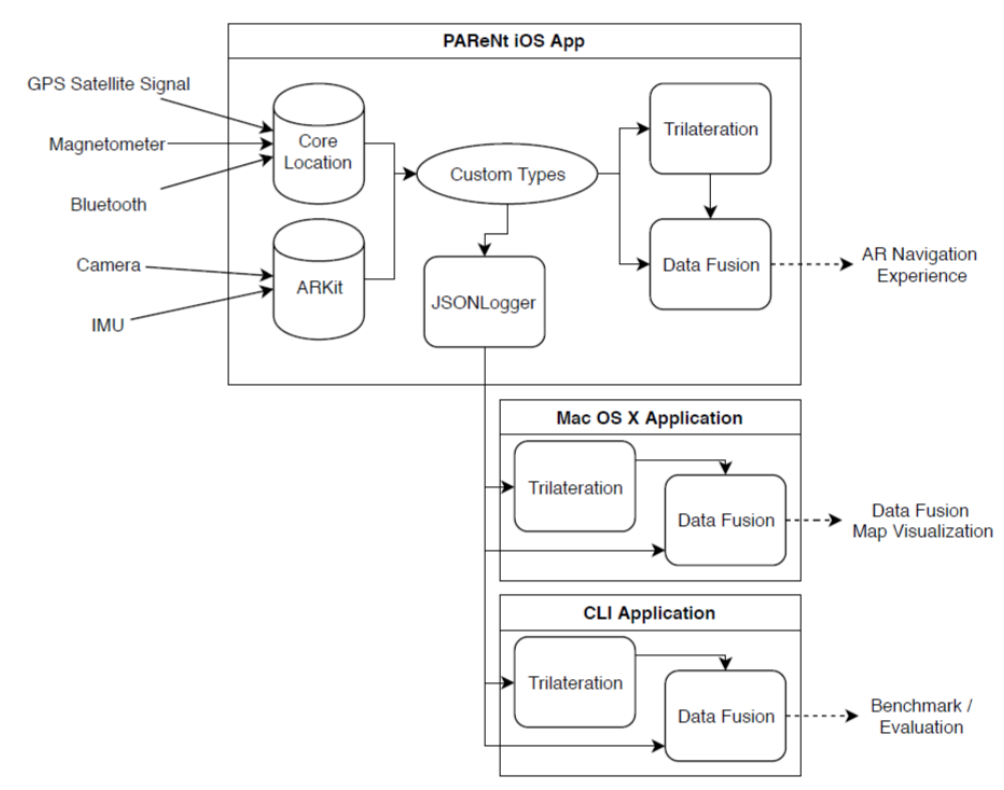
Figure 2. Overview of the